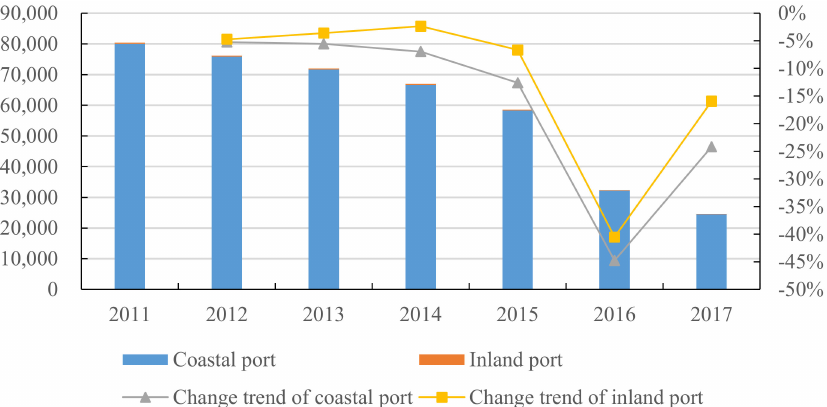
Figure 1. SO 2 emissions from inland and coastal ports (unit: ton). Note: The 2014 SO 2 emission data of coastal and ocean-going ships and inland ships in the Air Pollutant Emission Inventory of Marine in China (2017) calculate their proportion in China’s SO 2 emission in 2014 as a fixed proportion value from 2011 to 2017; then, by multiplying by the fixed proportion value according to the SO 2 emission data in the China Statistical Yearbook and Statistical Yearbooks of each province, the SO 2 emission data of each port can be